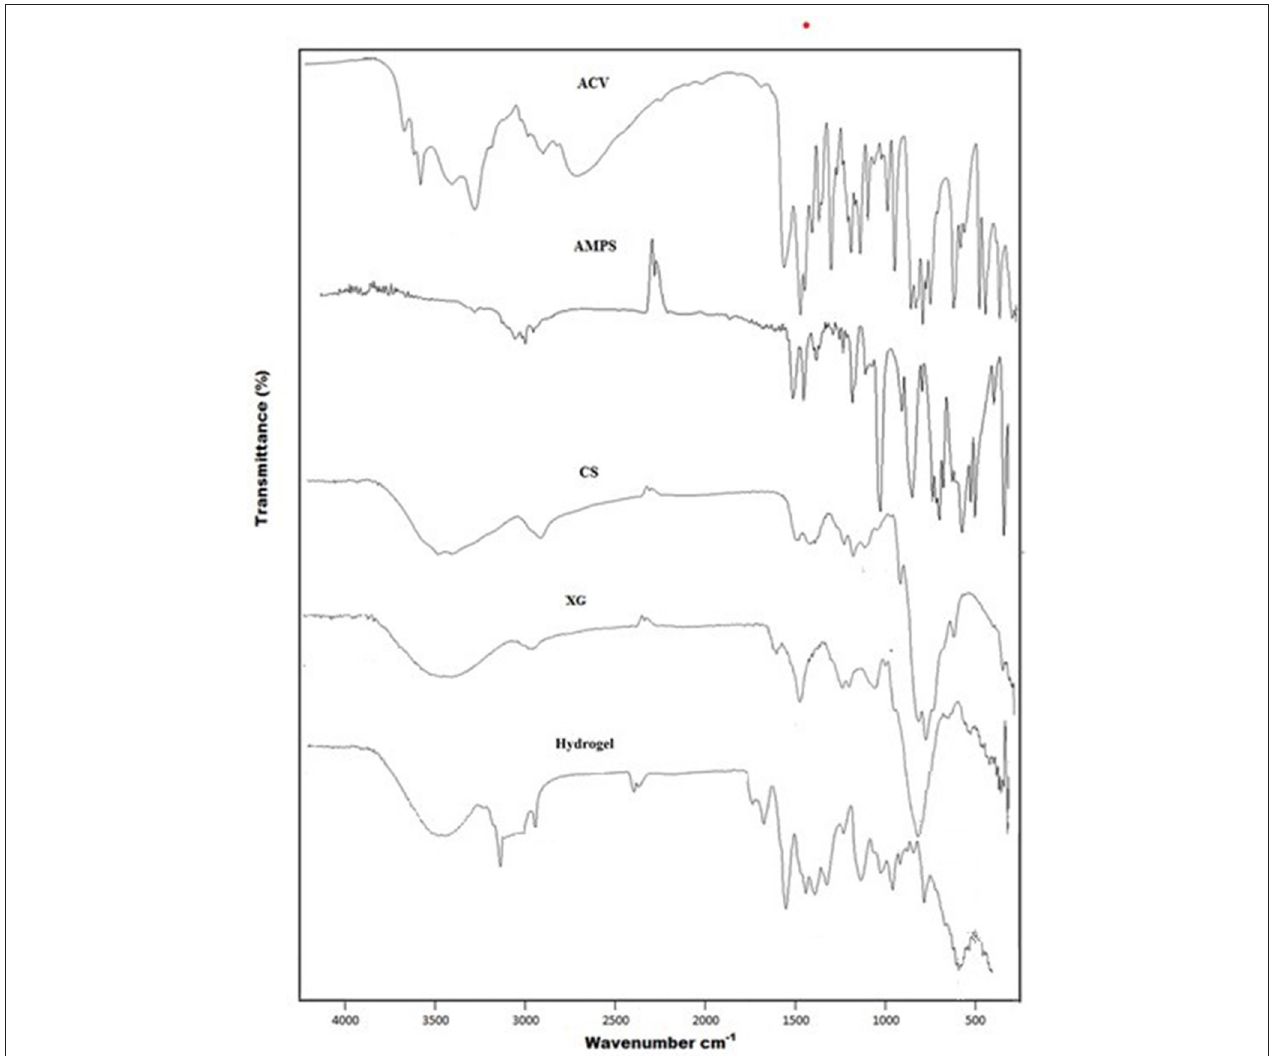
FIGURE 1 | FTIR Spectra of ACV, AMPS, CS, XG and Hydrogel.